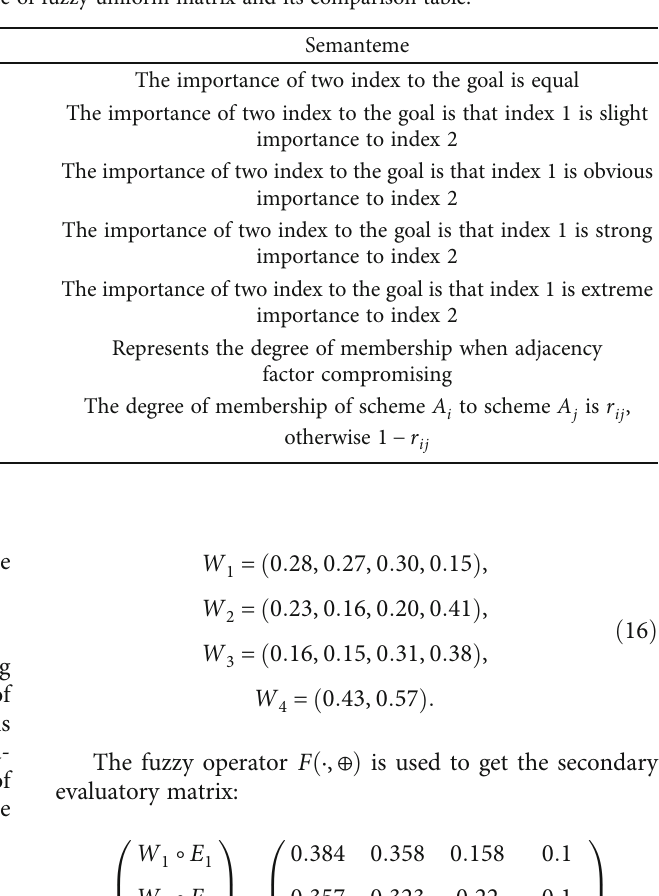
Table 2: The meaning of membership degree of fuzzy uniform matrix and its comparison